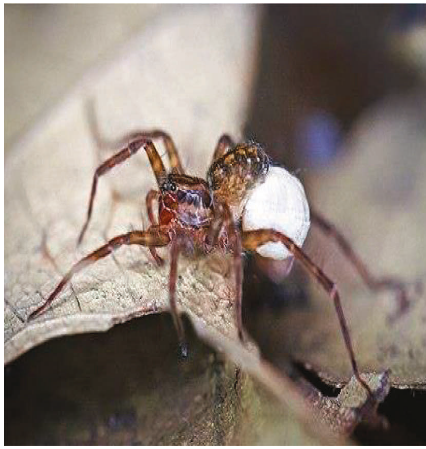
Figure 4: Pardosa milvina female with egg sac.